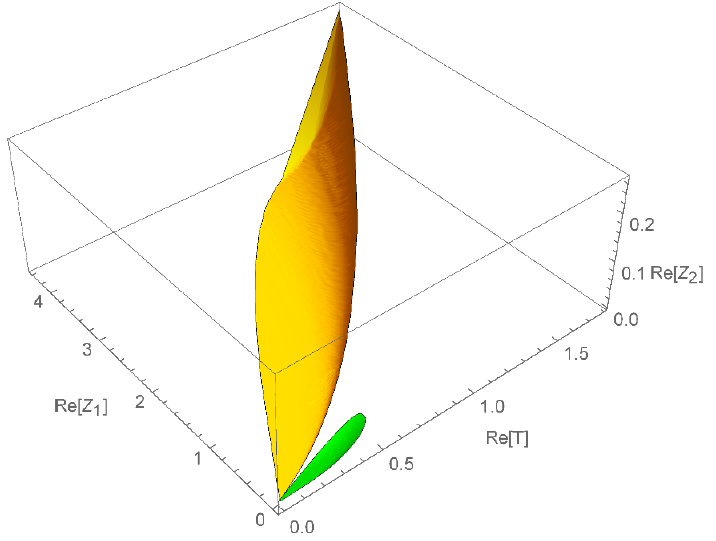
Figure 1 . This plot shows in yellow and green two regions for which V has metastable dS minima with N > 0 and N > 0. The smaller green region has no tachyons even if we open up the D 6 ; 1 D 6 ; 2 non-isotropic directions, while the yellow regions has tachyonic directions in that